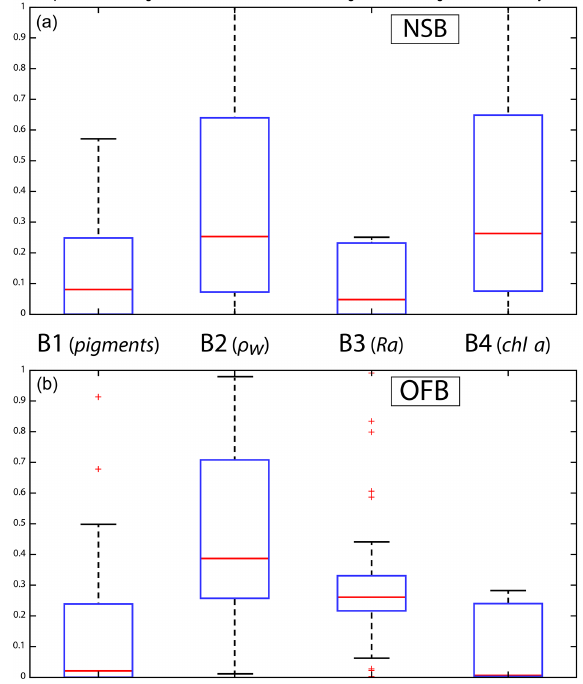
Figure 13. Box plot of the weights of the selected neurons during the decoding of the 28 February data. From left to right are the weights of blocks B1, B2, B3 and B4 (a) n the NSB region (long. [ − 20 ◦ , − 18 ◦ ], lat. [12 ◦ , 14 ◦ ]) and (b) in the OFB region (long. [ − 28 ◦ , − 26 ◦ ], lat. [12 ◦ , 14 ◦